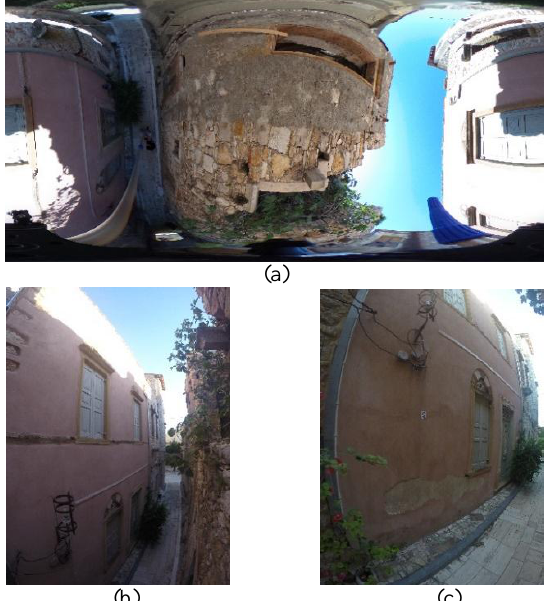
Figure 8: (a) Image taken by 360 o camera (b) image taken by GoPro camera at 4.25m high and (c) Image taken by GoPro camera at 1.50m high at the same second of capturing